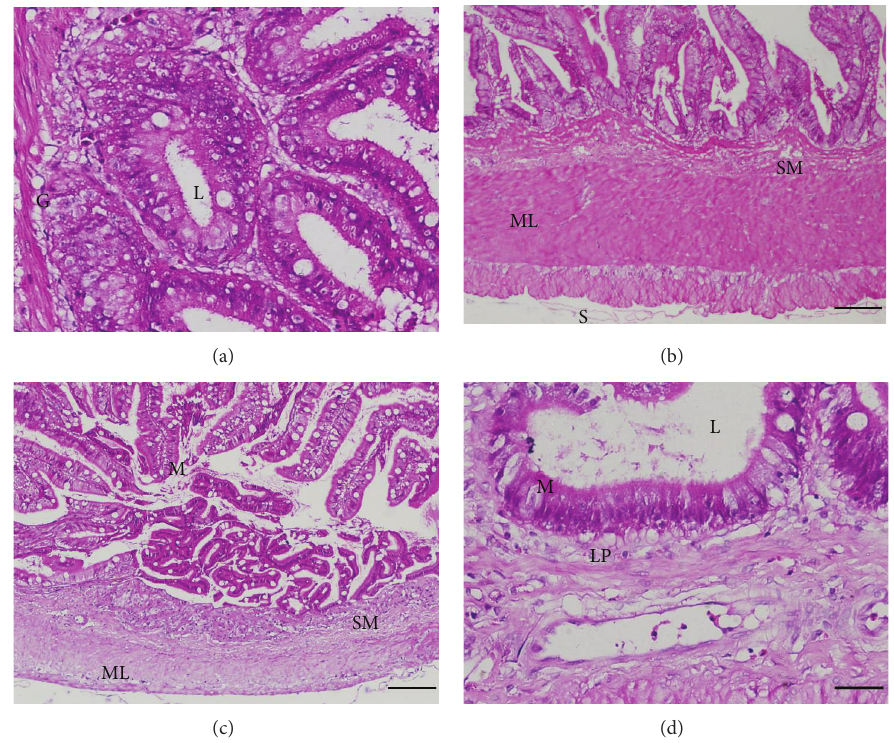
Figure 7: Histopathological observations in posterior part of cobia intestine injected with control PBS (i) and stimulation of cobia mixed with FKB, alum and 2137 (ii), 2395 (iii), and 1668 (iv) at 6 days after stimulation. Letters in the figure are denoted as M: mucosa epithelium, L: lumen, ML: muscular layer, SM: submucosa, LP: lamina propria, S: serosa, and G: goblet cells.